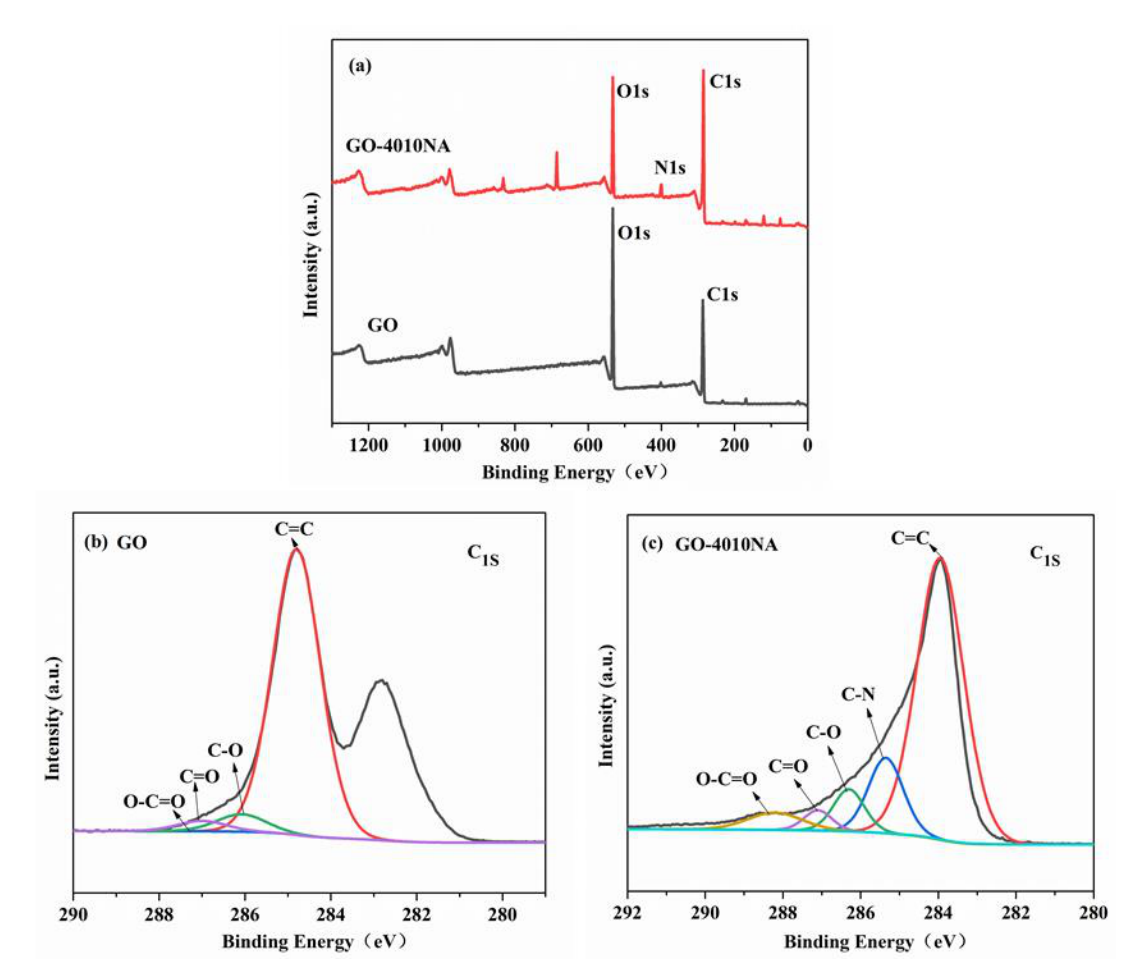
Figure 5. ( a ) XPS survey scans for GO and GO-4010NA, XPS C 1s core-level spectra for ( b ) GO and ( c ) GO-4010NA.